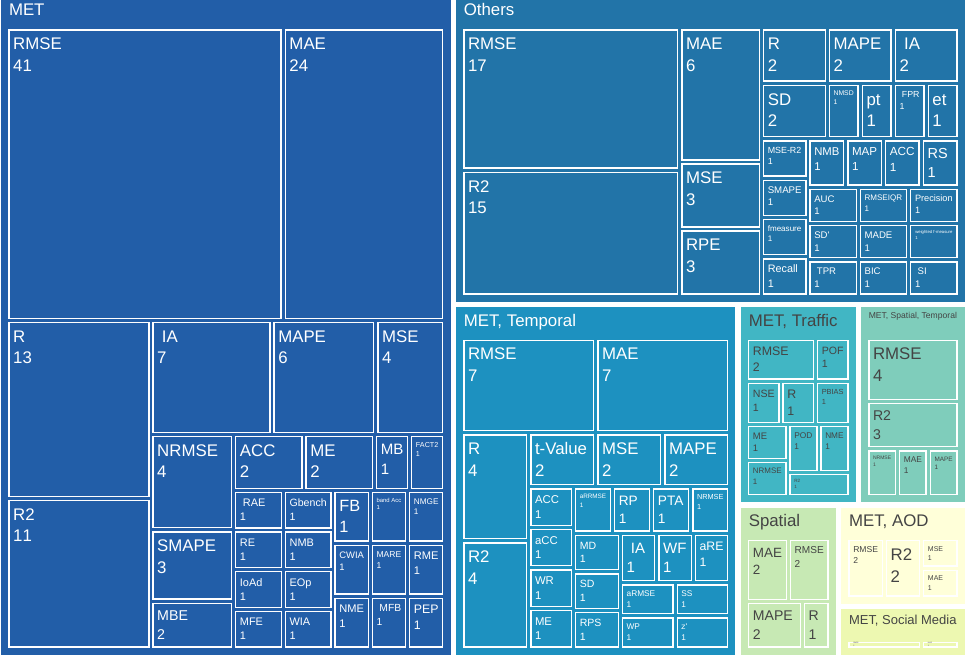
Figure 12. The number of publications of dataset combinations in terms of evaluation